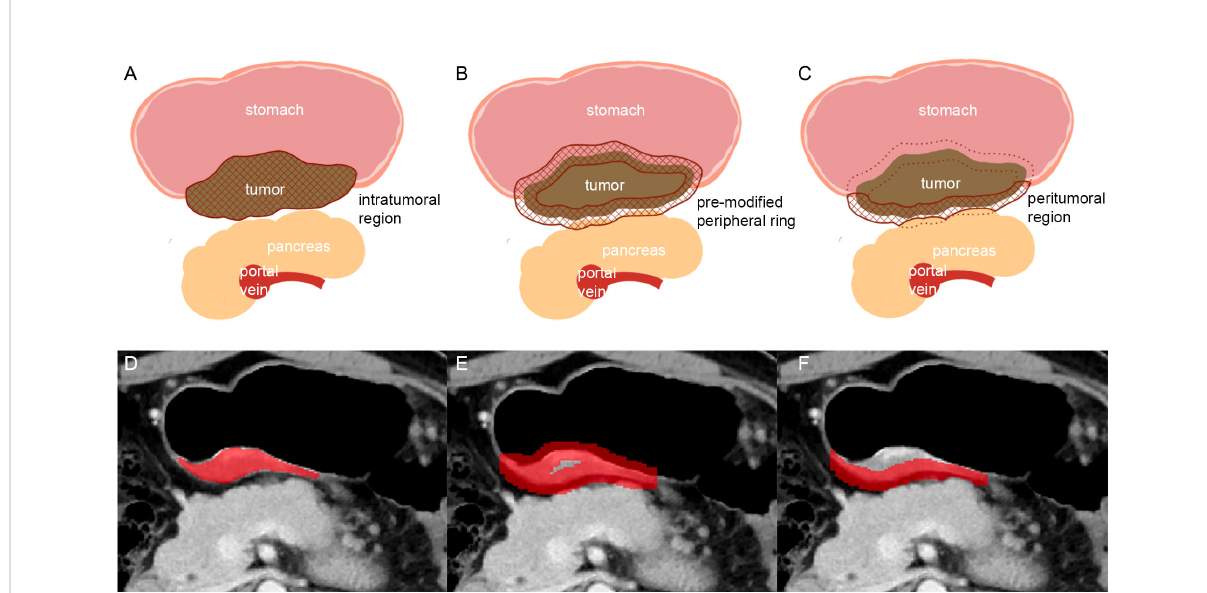
FIGURE 2 Schematic illustration of the steps followed to draw intratumoral and peritumoral ROIs. (A, D) : the largest axial sections of gastric lesions were manually contoured (intratumoral region of ROI). (B, E) : the pre-modi fi ed peripheral ring was automatically generated. (C, F) : modifying was conducted manually on the pre-modi fi ed peripheral ring to exclude the gastric cavity and the part covering the surrounding organs (pancreas) and large vessels (in C: solid line: peritumoral region of ROI; dotted line: the part of ROI been